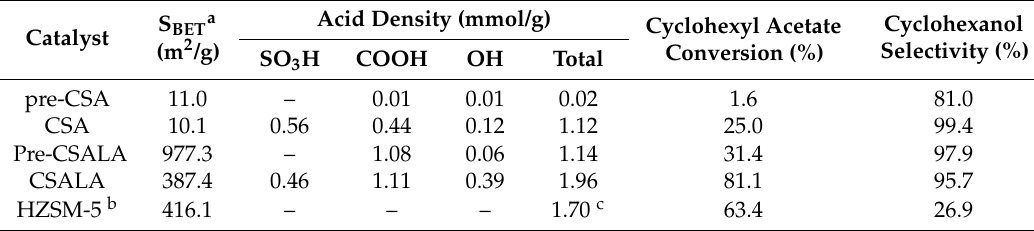
Table 1. Catalytic performance of carbon solid acid (CSA) for the hydrolysis of cyclohexyl acetate. S Catalyst